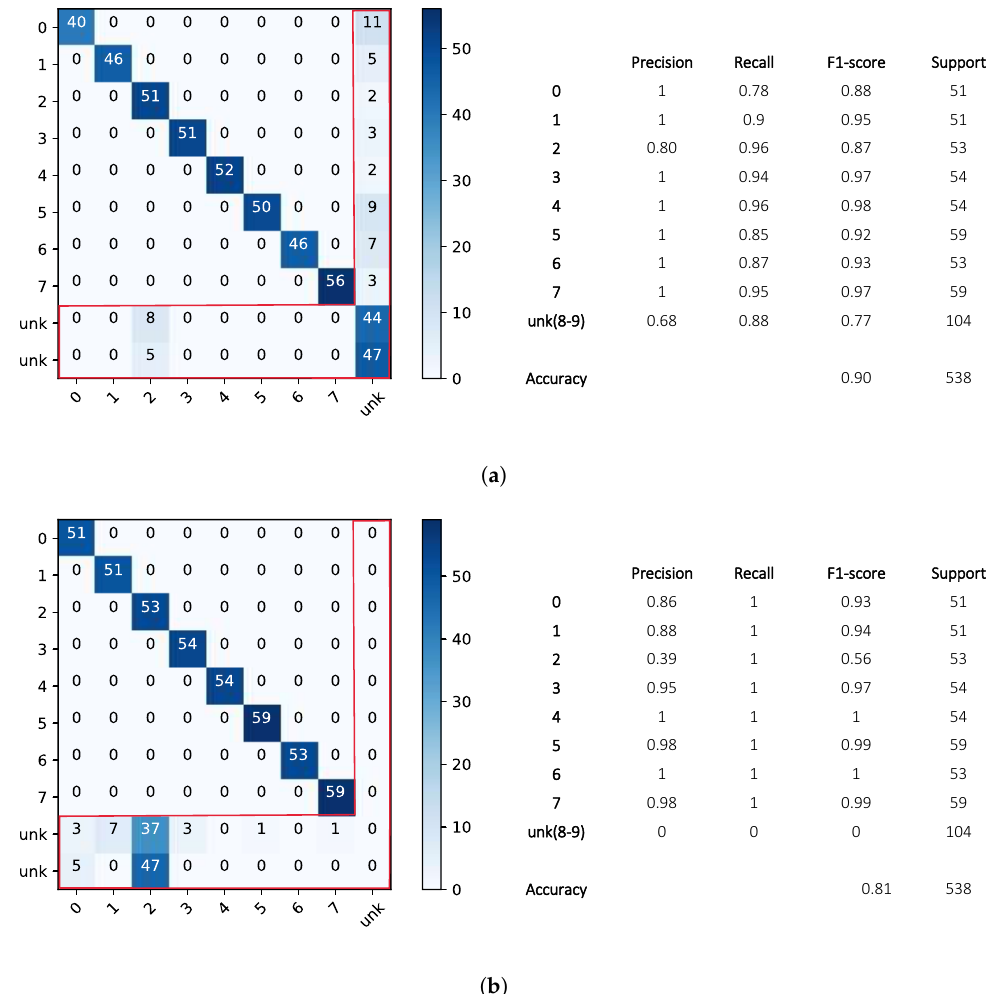
Figure 5. Confusion matrix and the corresponding classification reports using ( a ) Openmax, ( b ) Softmax. Turning our attention to the precision index, Figure 6d shows the Pr of the unknown class. In particular, we can see from the Openmax diagram (the red curve) that Pr remains constant at 68% as long as the threshold does not exceed 0.5. Subsequently, it begins to decrease as a threshold larger than 0.5 is used and more images from known classes are rejected. Differently, we can see from the Softmax diagram that using thresholds between 0.38 and 0.48, the Pr is equal to 100%. Next, when λ ≥ 0.48, the Pr is unstable and changes in the range ( 75%, 92% ) . Finally, when λ approaches 1, both classifiers tend to the same ≈ 19.3%. Note that the blue curve is not drawn for thresholds lower than value, Pr = 104 538 0.38, as we would obtain 0 in Equation (4), which is due to the inability of the Softmax 0 classifier to reject unknown images by such thresholds. Let us now evaluate the Pr of Openmax in known and unknown classes as shown in Figure 6e. We can see that apart from class 2 and Unk , the Pr of other classes is 100% and the threshold does not have any influence on them. The dissimilar behavior of class 2 compared to the other known classes is due to the fact that when unknown images are misclassified, they are assigned to the 2 class. However, by increasing the threshold, the Pr of this class increases and tends gradually to